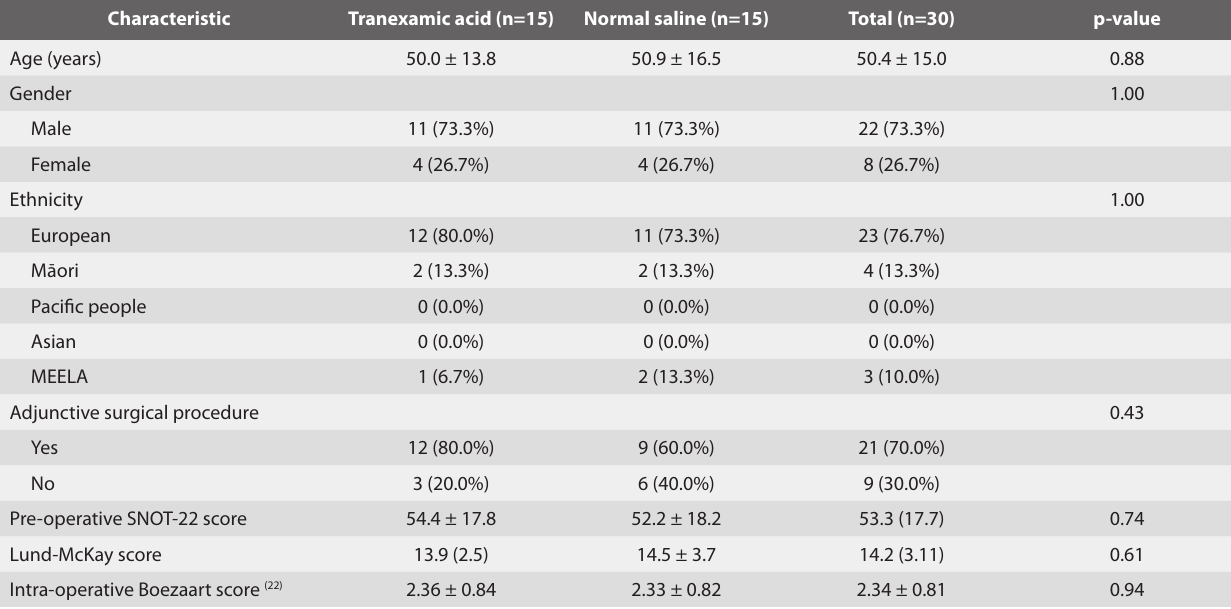
Table 1. Baseline patient characteristics.